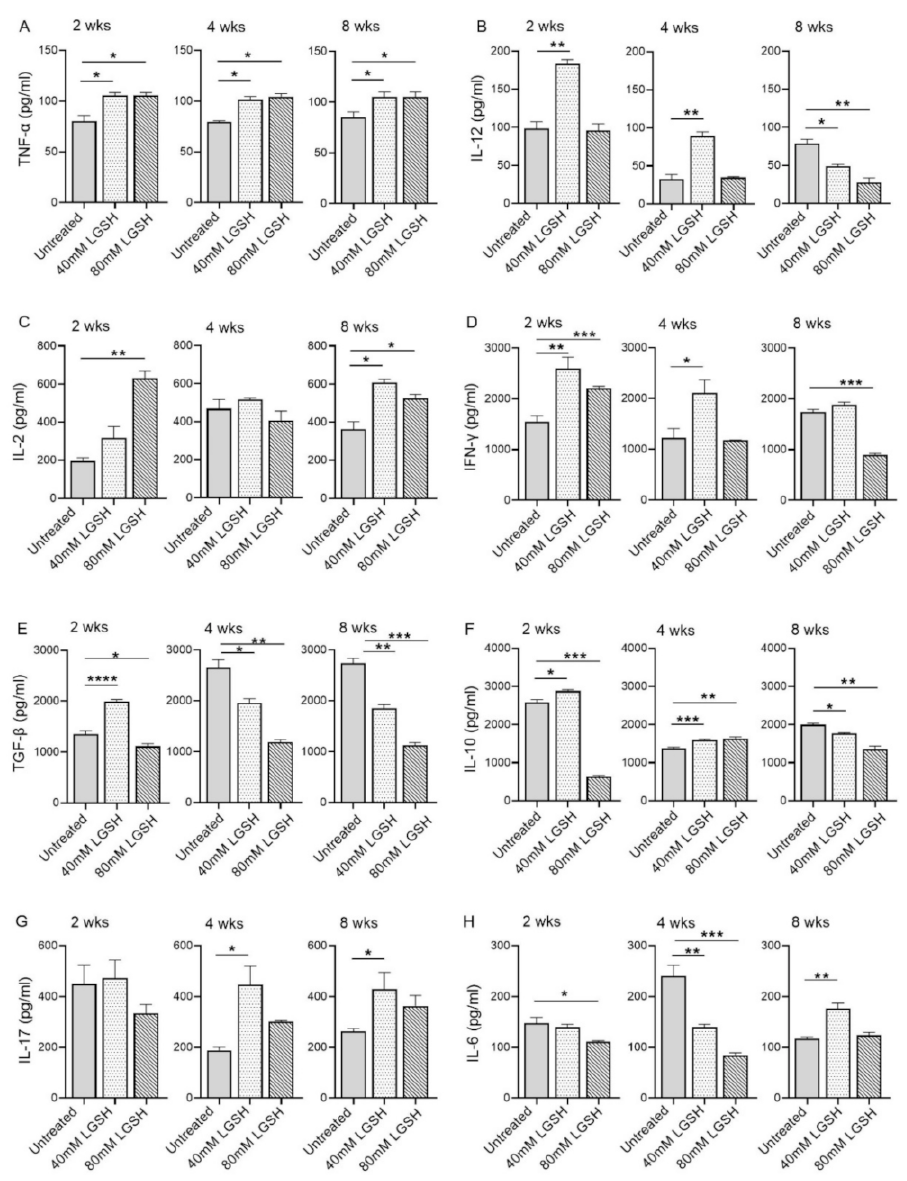
Figure 4. L-GSH treatment significantly affected the production of pro- and anti-inflammatory cytokines in the M. tb -infected mice lungs. The proinflammatory cytokines TNF- α ( A ), IL-12 ( B ), IL-2 ( C ), IFN- γ ( D ) and anti-inflammatory molecules TGF- β ( E ), IL-10 ( F ), as well as the IL-17 ( G ) and IL-6 ( H ) levels were measured in the lung lysates of the M. tb -infected untreated mice and the 40 mM or 80 mM L-GSH-treated mice at 2 weeks, 4 weeks, and 8 weeks post-infection. All of the values plotted for each group represent the mean values +/ − standard deviation. One-way ANOVA with Tukey’s multiple group post correction was applied to determine the significance between the groups and a p -value of <0.05 (*) was considered significant. ** p < 0.01; *** p < 0.001; **** p < 0.0001 Statistical analysis was performed using GraphPad Prism Software 8. The sample size is 6 mice (n = 4) per group, per time